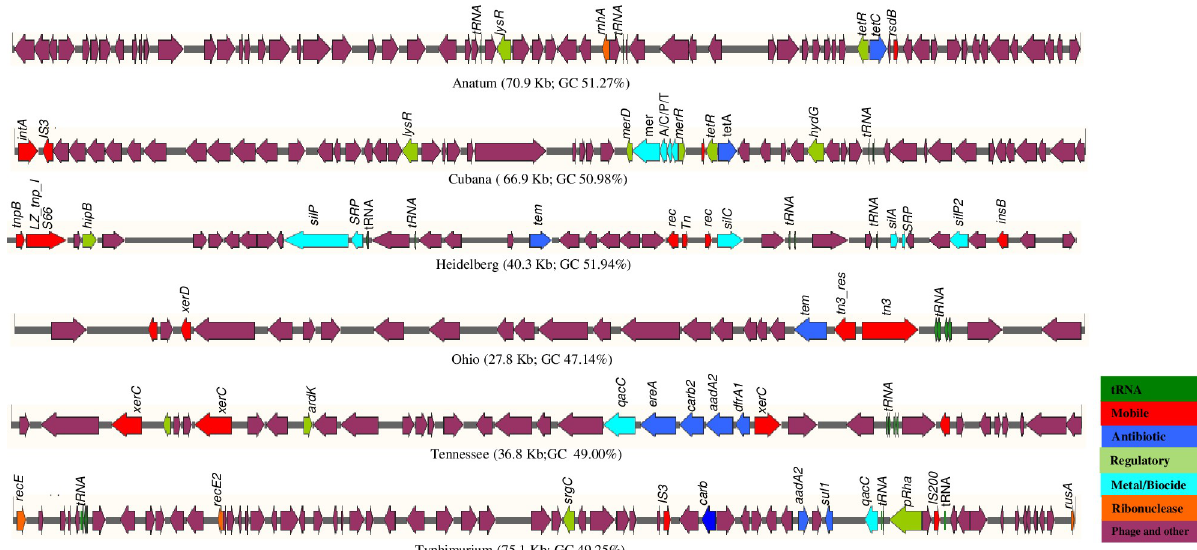
Fig 5. Examples of integrated bacteriophage. Cargo genes are annotated, such as antibiotic and other resistance genes ( Hg resistance gene [ mer A/C/ P/T/ and mer regulators mer D/R; S . Cubana], Ag resistance genes [ sil A/C/P/P2, SRP; S . Heidelberg], quaternary ammonium compound gene [ qac C; S . Tennessee and S . Typhimurium]). The arrow shows orientation of the genes in the contigs and genes are color coded to define different gene categories.